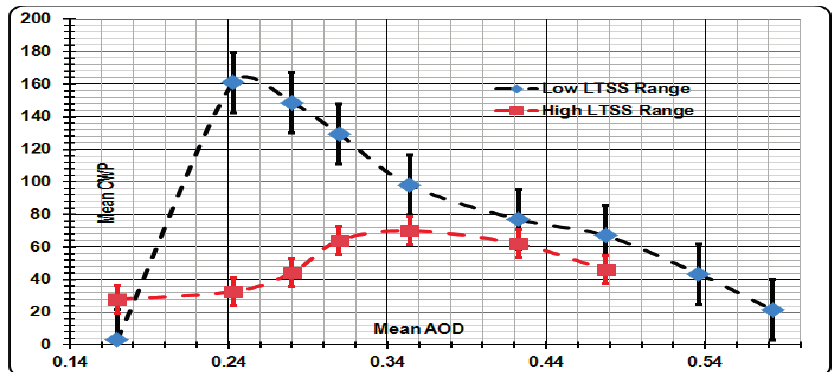
Figure 14. Response of cloud water path (CWP) to increasing aerosol optical depth (AOD) in unstable and stable atmospheric environments. For NAADR_Land, the threshold AOD necessary to shift from moistening to drying processes is much larger in stable environments.